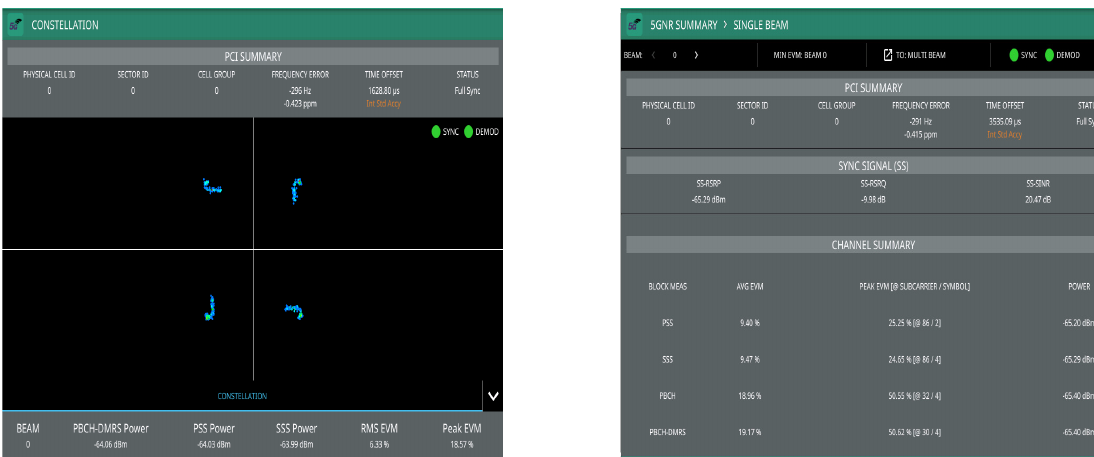
Figure 15. Demodulated and 5G summary of direct link though the Anritsu analyzer.